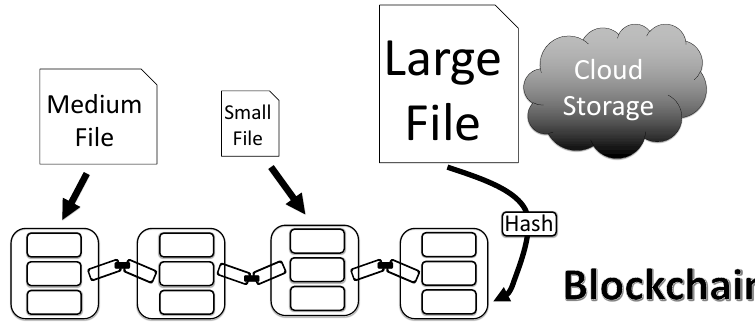
Figure 4. If the size of the files is a limiting factor for the system, large files can be uploaded to cloud storage and only a hash of the file can be saved to the blockchain. By doing so, the storage on the blockchain is minimal and large files take up no more space than smaller files. However, this comes with some sacrifices as only integrity will be guaranteed, whereas the file may not be available if it gets deleted in the